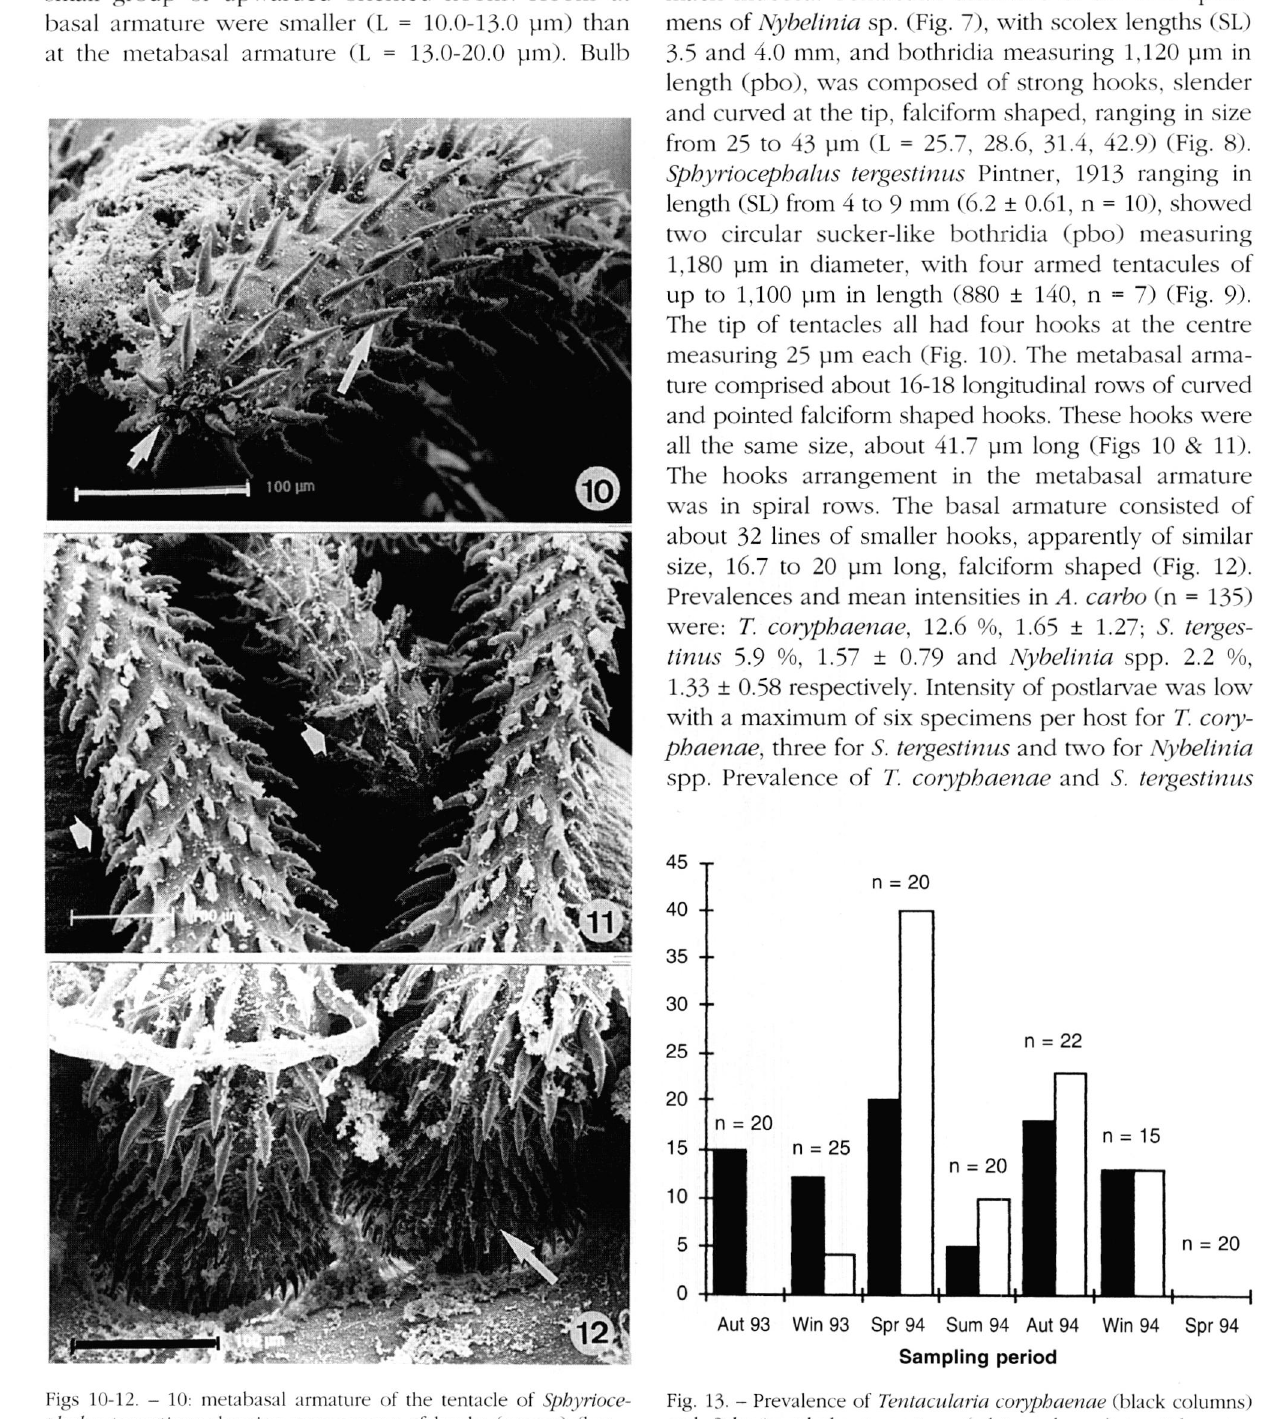
Fig. 13. - Prevalence of Tentacularia coryphaenae (black columns) and Sphyriocephalus tergestinus (white columns) in Aphanopus carbo related to season of the year. Abbreviations: Aut (autumn): Spr (spring); Sum (summer); Win (winter); n = number of hosts exa